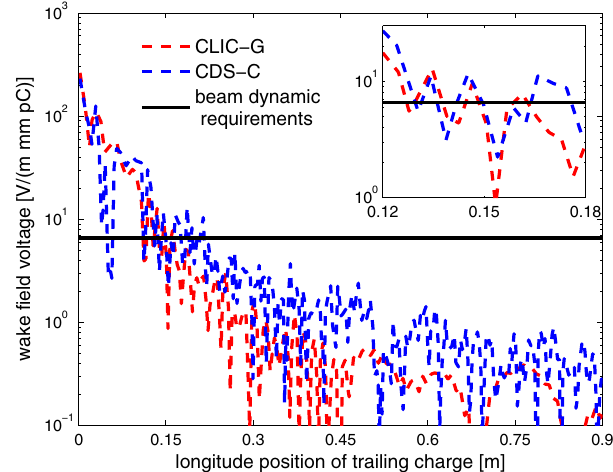
FIG. 15. Wakefield potential of CDS-C compared with CLIC-G.